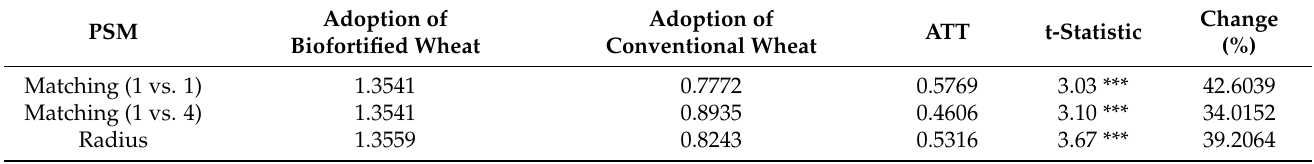
Table 6. The average treatment effects of the adoption of wheat biofortification on ROI for the